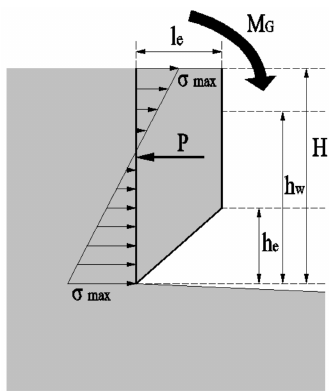
Figure 3. Normal stress distributions on the fixed end section of the headcut.